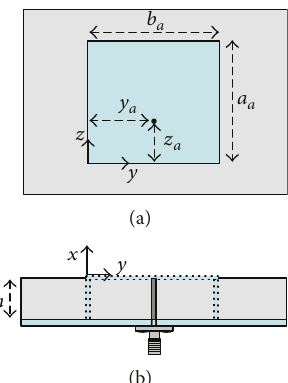
Figure 1: Hybrid microstrip antenna: (a) top view and (b) lateral view.